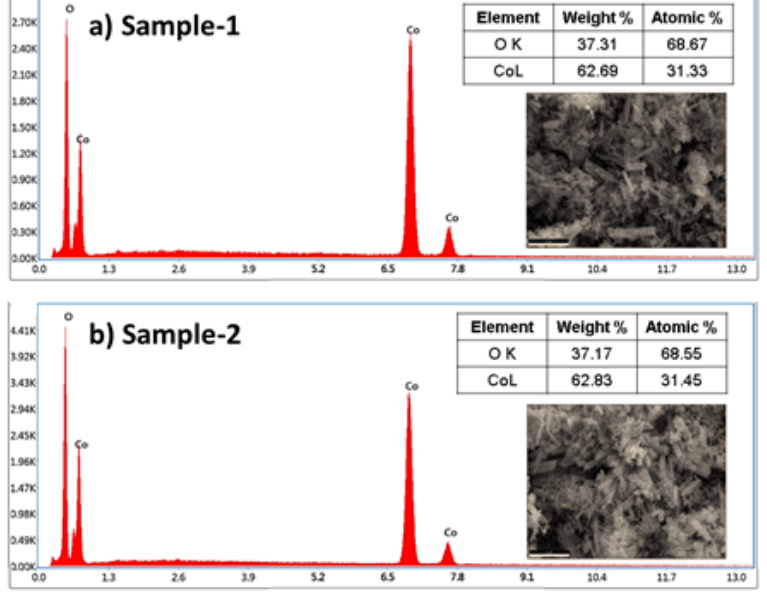
Figure 2. EDS spectra of ( a ) pure Co 3 O 4 and ( b ) Co 3 O 4 nanocrystals prepared with polyethyleneimines.